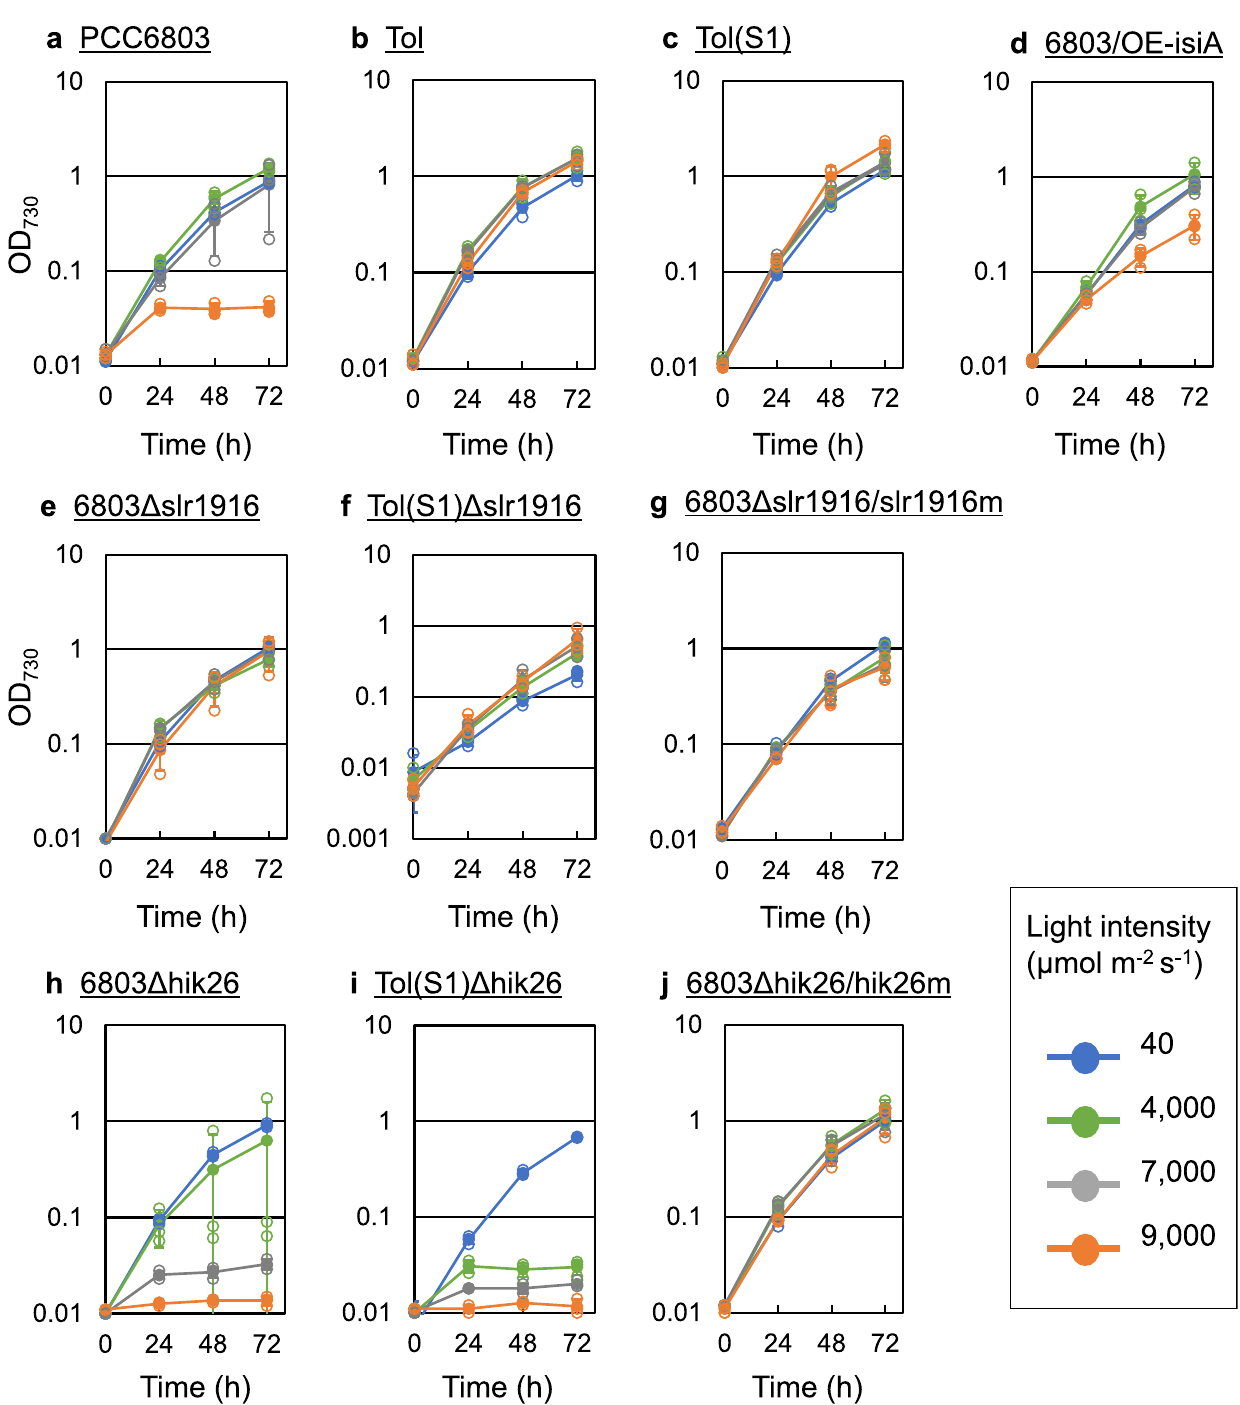
Fig. 5 Reverse engineering based on transcriptome and whole-genome re-sequencing analyses. a PCC6803, b Tol, c Tol(S1), d 6803/OE-isiA, e 6803 Δ slr1916, f Tol(S1) Δ slr1916, g 6803 Δ slr1916/slr1916m, h 6803 Δ hik26, i Tol(S1) Δ hik26, j 6803 Δ hik26/hik26m strains. Culture under a light intensity of 40 μ mol m − 2 s − 1 was performed using an LED plate, and cultures under other light intensities (4000, 7000, and 9000 μ mol m − 2 s − 1 ) were performed using point source LED. The fi lled and open circles represent averages and individual data points in the biological triplicate experiments. Error bars indicate standard deviation from triplicate experiments. Note that the errors of the growth curve of the 6803 Δ hik26 strain under 4000 μ mol m − 2 s − 1 were large because in the triplicate experiments similar growth as that of PCC6803 was observed in one culture experiment and severe-inhibited growth was displayed in remaining two culture experiments. In the 6803 Δ slr1916/slr1916m and 6803 Δ hik26/hik26m strains, the mutated genes were introduced at the neutral sites, not at their natural positions.